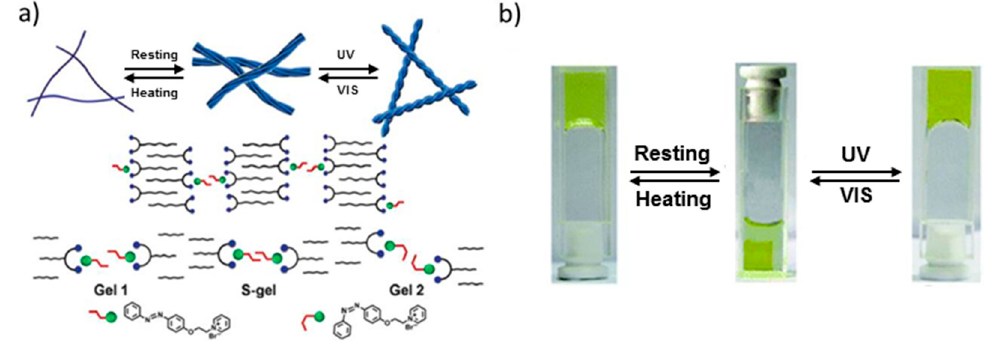
Figure 5. ( a ) Schematic illustration of hierarchical co-assembly by amphiphilic dendron and azobenzene components through electrostatic interaction; ( b ) thermal and photo-switched reversible control on network composition. Adapted from [20] with permission of The Royal Society of Chemistry.